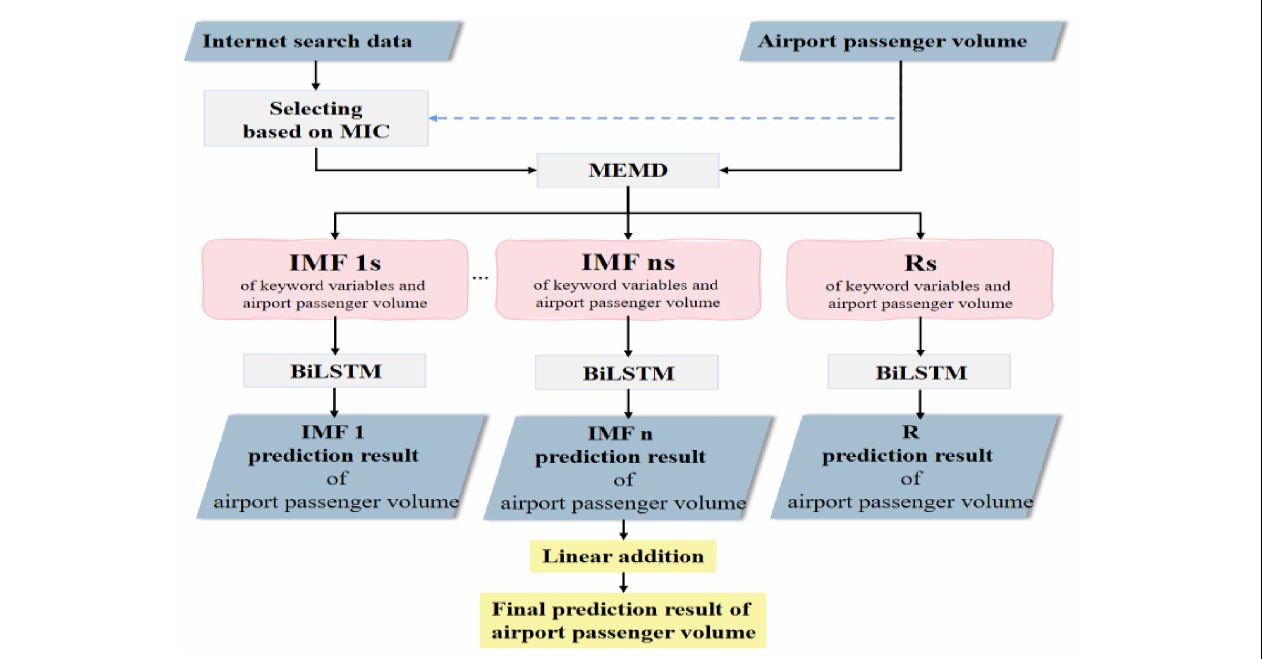
FIGURE 3 | Structure of MIC_MEMD_BiLSTM prediction